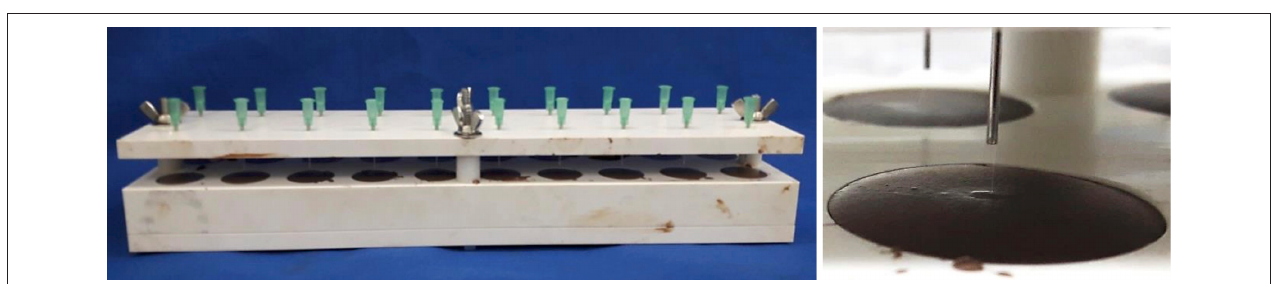
FIGURE 1 | Mold used to produce the specimens for the single fiber pullout test and detail of the fiber positioning in the cannula.